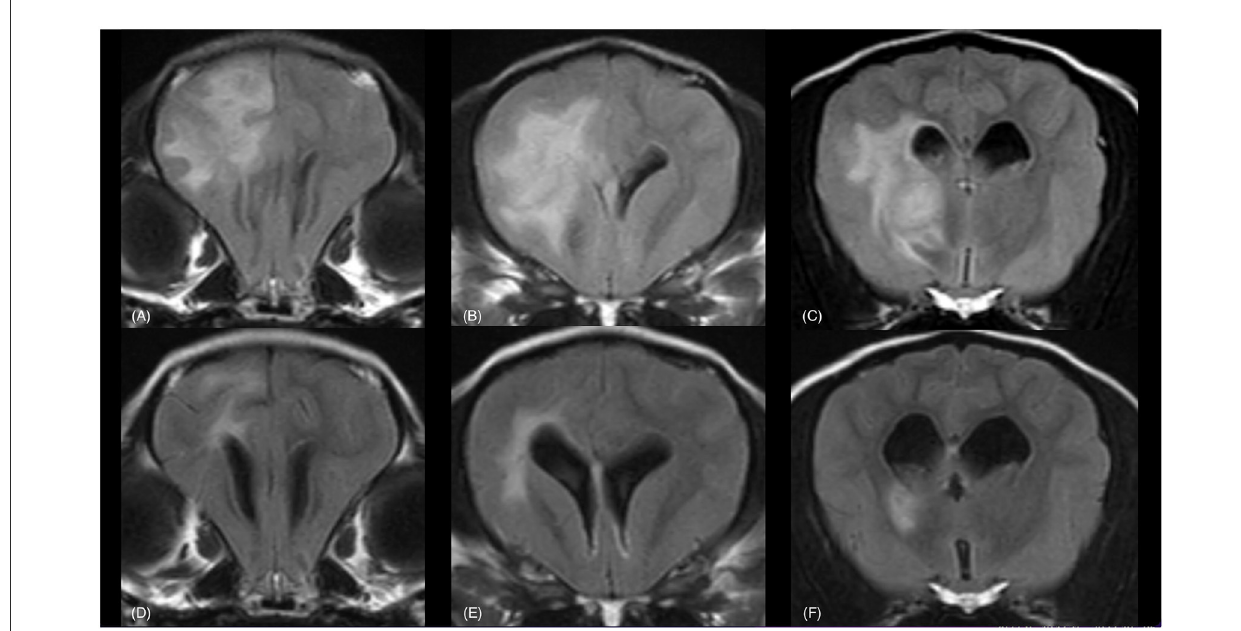
FIGURE3 MRI of a 4-year-old Chihuahua (dog 9). Partial resolution of lesions is visible. In the upper row the brain is imaged at the time of diagnosis (A–C) and in the bottom row the brain is imaged at the corresponding levels three months after radiation therapy (D–F) . The sequences are from left to right in a rostro-caudal direction at the rostral commissure (A, D) , the lateral ventricles, caudate nucleus, internal capsule and body of the corpus callosum (B, E) and the optic chiasm (C, F) . Transverse FLAIR (TR = 11,000ms, TE = 125ms, TI = 2,800ms, ST = 2.5mm) (A–F) images are provided. TR, Time of Repetition; TE, Time of Echo; TI, Time to Inversion; ST, Slice Thickness. A large, single, irregular, and apparently well-delineated, hyperintense lesion within the left forebrain is visible, mainly affecting the white matter (A–C) . The lesions are partially resolved at the time of follow-up MRI (D–F) .